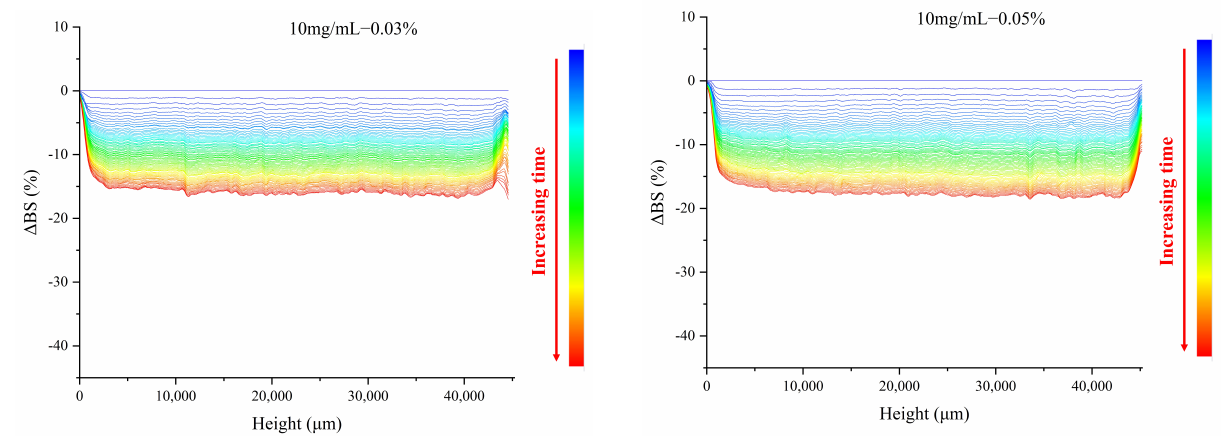
Figure 5. The ∆ BS of MP O/W emulsions with different concentrations of TPP during 30